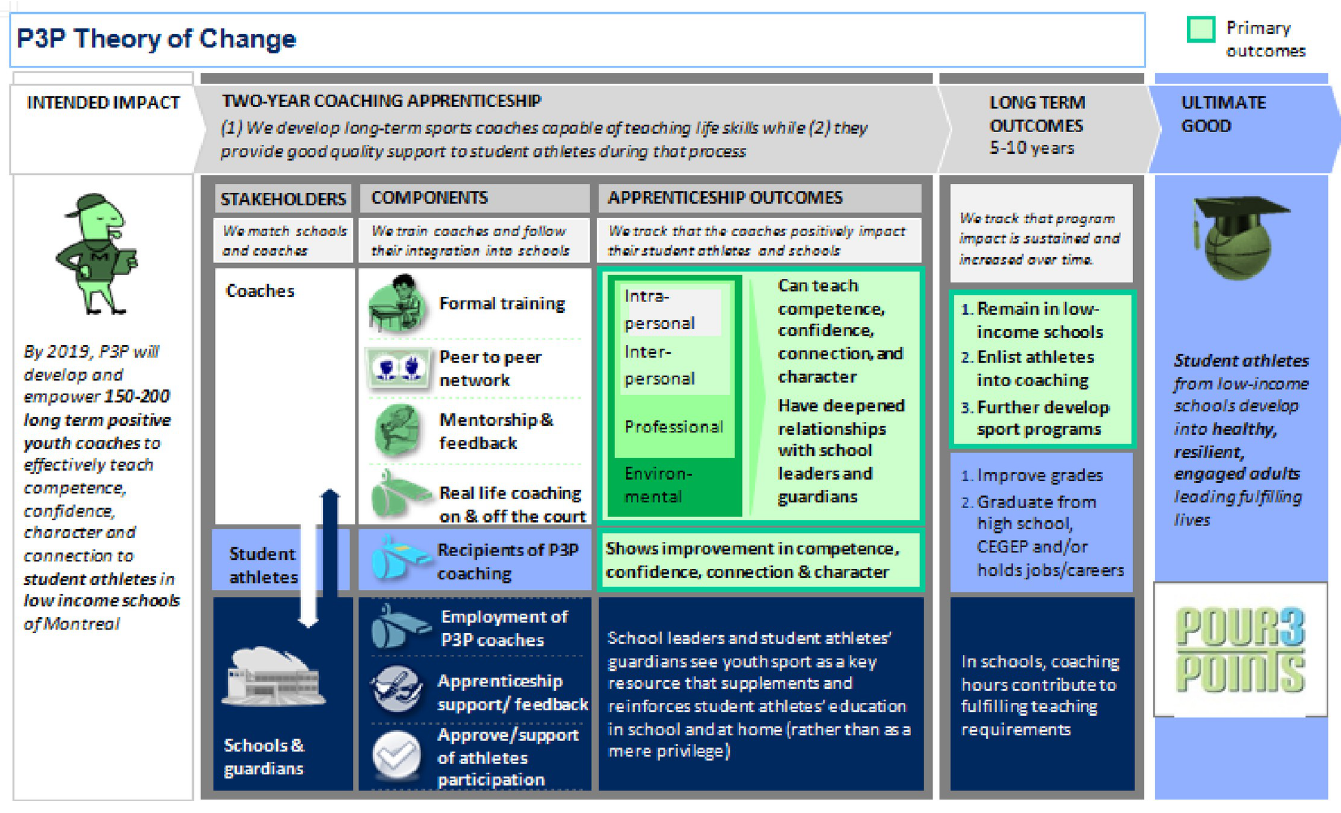
Fig 2. First P3P training program’s logic